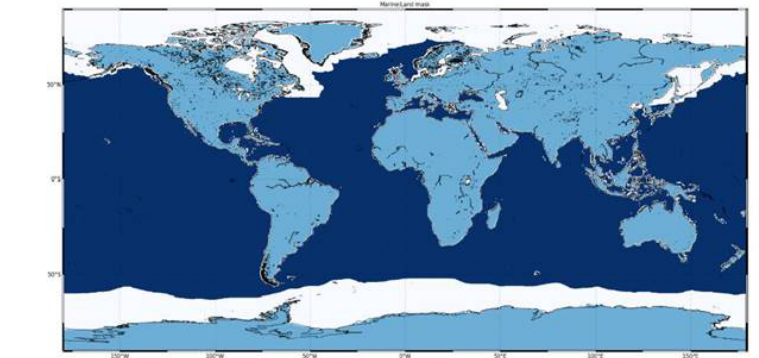
Figure 2. Land/Sea mask showing the regions of responsibility for data production for mid 2020 onwards (expected). Data over land (light blue) are produced and disseminated by ESA; those over the ocean (dark blue) by EUMETSAT; some regions (white) are common to both, including the polar regions of maximal sea-ice extent and major inland water bodies (e.g., Caspian Sea, Great Lakes, Lake Victoria). As users for terrestrial data may benefit from the records just offshore, and those working in the coastal zone benefit from having the data just inland, these regions extend 25 km outward/inward from the coast to avoid researchers needing to gather data from two